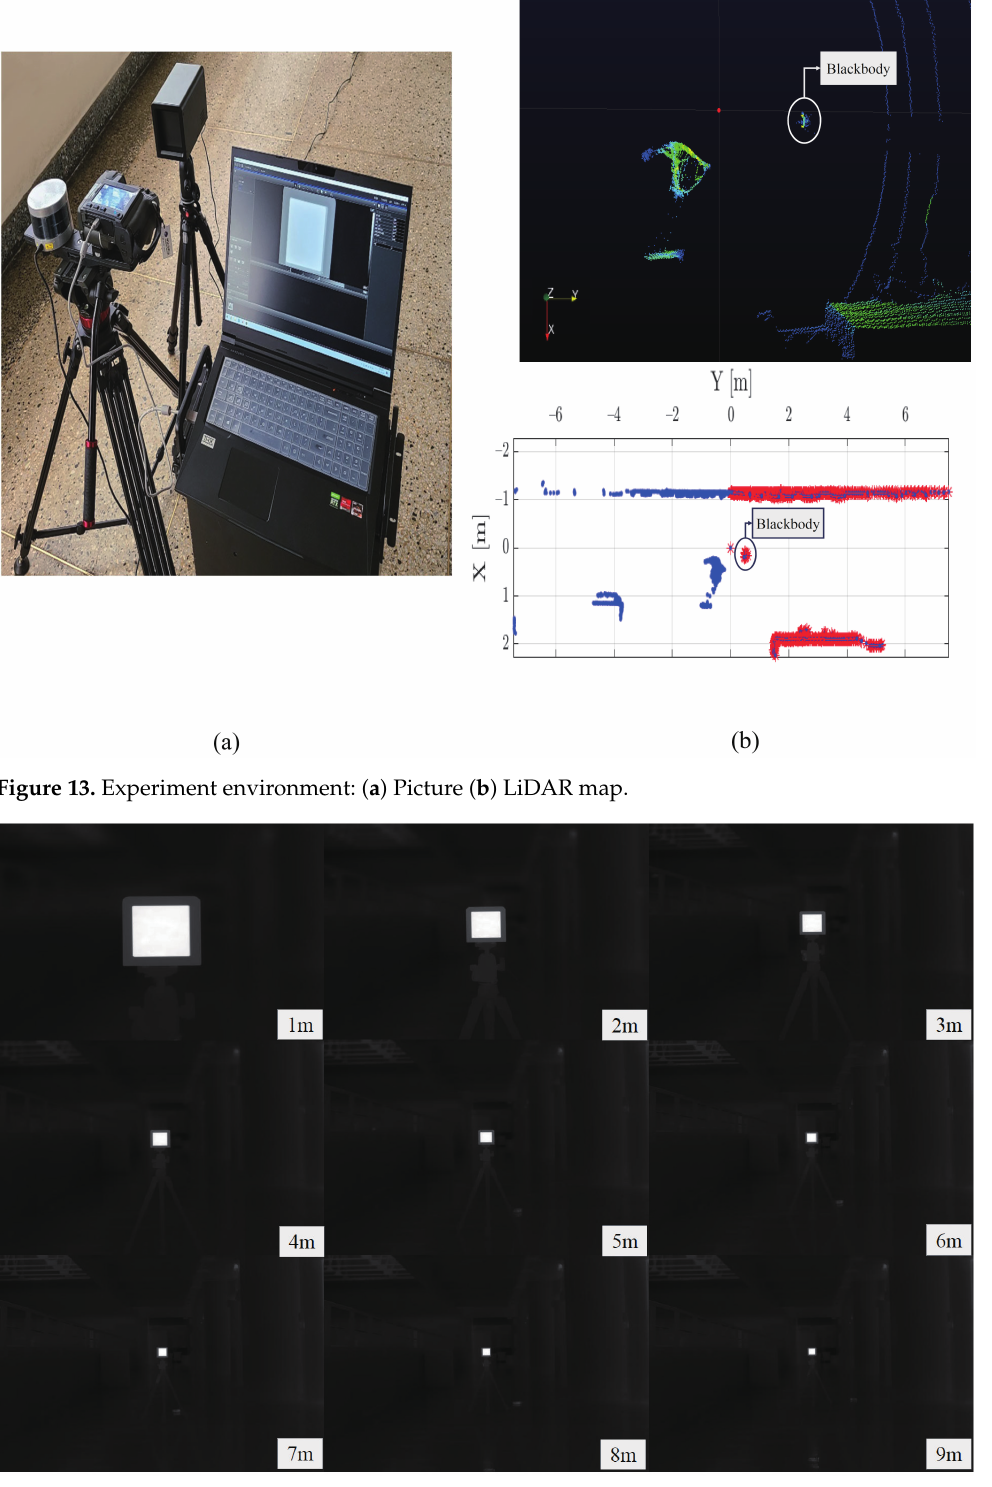
Figure 14. Blackbody thermal image acquired through an infrared camera (about 1–9